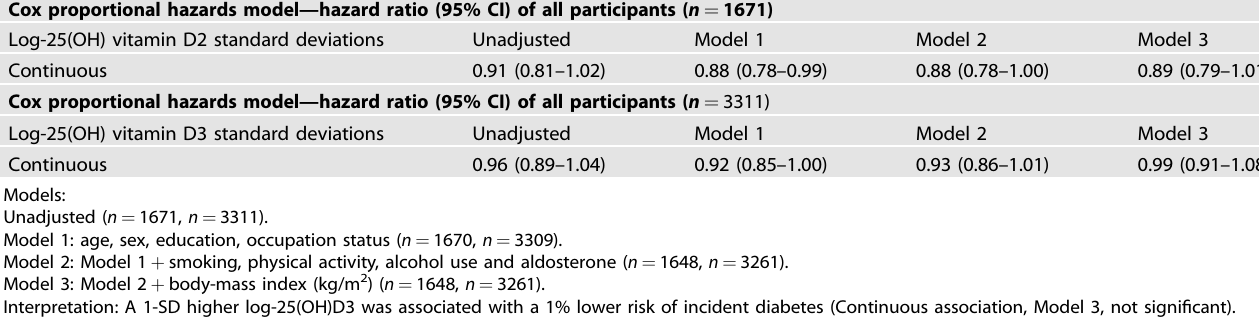
Table 4. The association of log-25(OH) D2 and D3 with incident diabetes. Cox proportional hazards model — hazard ratio (95% CI) of all participants ( n = 1671) Log-25(OH) vitamin D2 standard deviations Cox proportional hazards model — hazard ratio (95% CI) of all participants ( n = 3311) Log-25(OH) vitamin D3 standard deviations